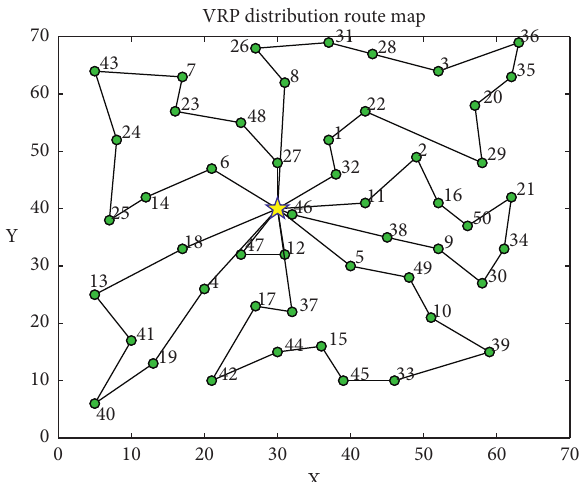
Figure 14: Reference [40] optimal circuit